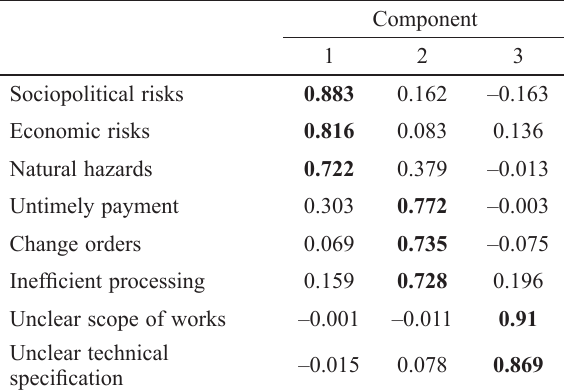
Table 3. Exploratory factor analysis for causes of